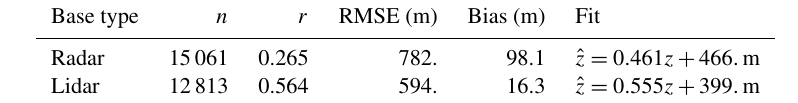
Table 5. Statistics of the relationship between ceilometer and 2B-GEOPROF-LIDAR z ; see Table 2 for a description of the statistics provided.